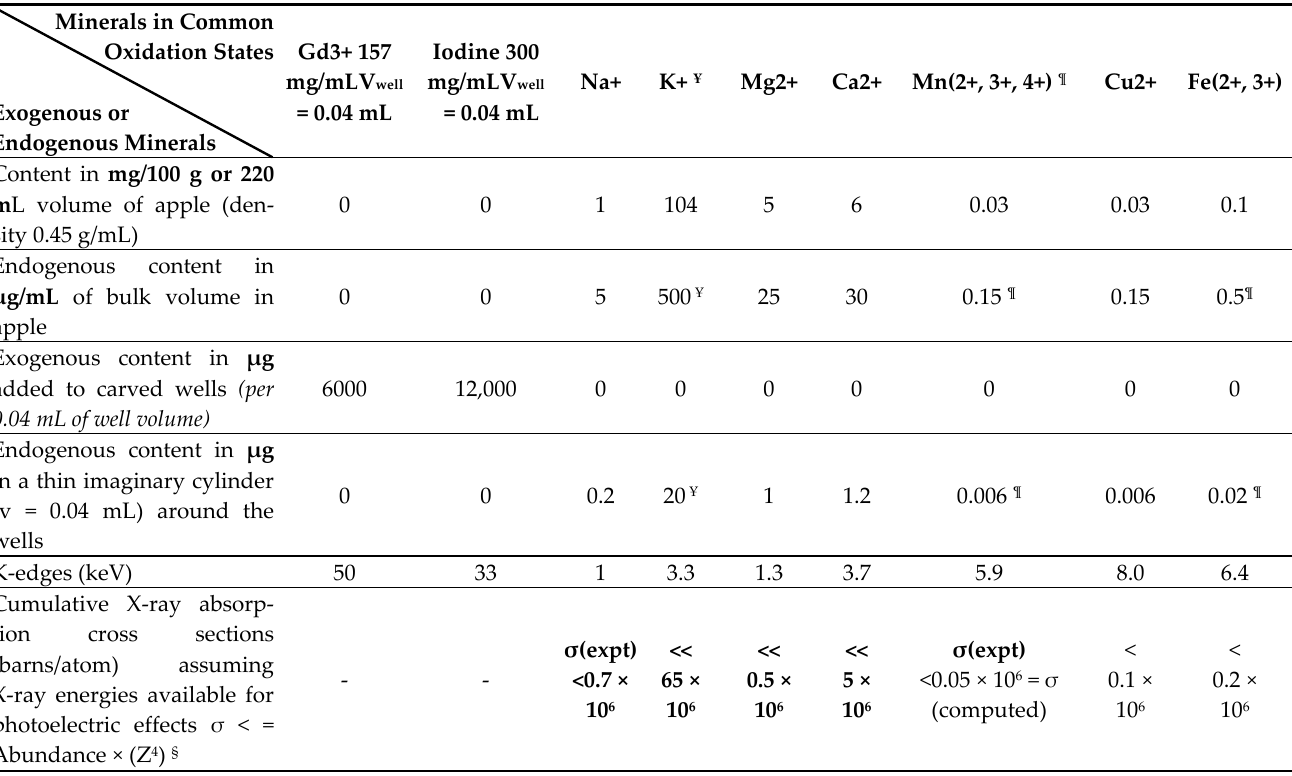
Table 1. Endogenous mineral content in red delicious apple and estimated amount available for transmetallation or chelation in a thin imaginary cylinder around the wells.